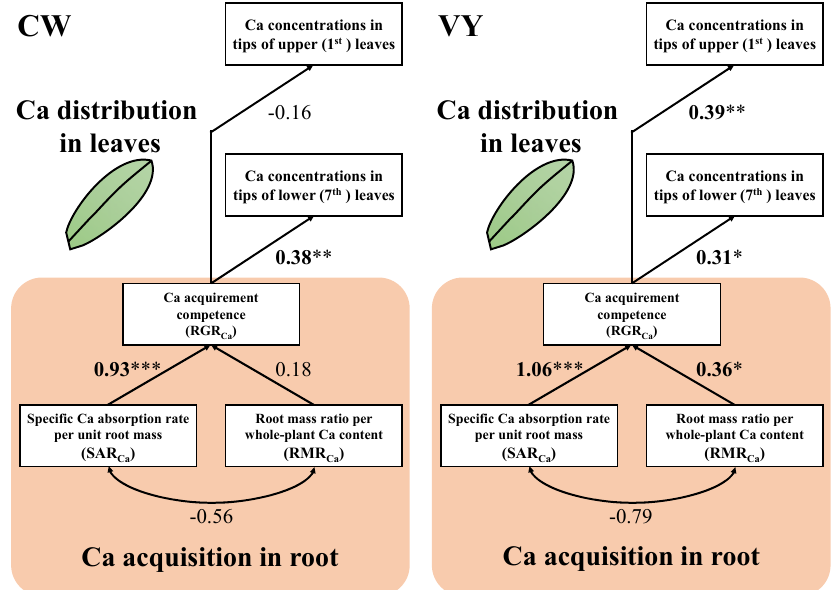
Figure 2. Path model of Ca acquisition competence (RGR Ca ), specific absorption rate per unit. root mass (SAR Ca ), root mass ratio per whole ‐ plant Ca content (RMR Ca ), and Ca concentrations in the tips of upper (1st) and lower (7th) leaves under three different Ca treatments for ‘Celeb Wine ‘(CW) and ‘Voyage Yellow’ (VY) lisianthus cultivars. Single ‐ arrow lines represent causal relationships and the numbers above the arrows are the standardized path coefficients. Double ‐ arrow lines represent correlations and the numbers above the arrows are standardized correlation coefficients. The significance levels of the path effects are indicated by * p < 0.05; ** p < 0.01; *** p < 0.001.